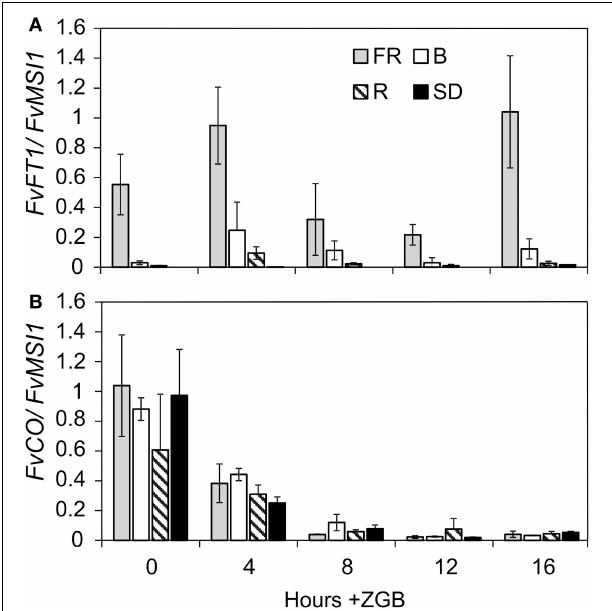
FIGURE 4 | The effect of the end-of-day light quality treatments on the daytime expression of FvFT1 and FvCO in Hawaii-4. (A) Relative expression of FvFT1 and (B) FvCO in different light quality treatments at 0, 4, 8, 12, and 16h after lights were switched on (ZGB = zeitgeber time). Values are means of three biological replicates ± SD .